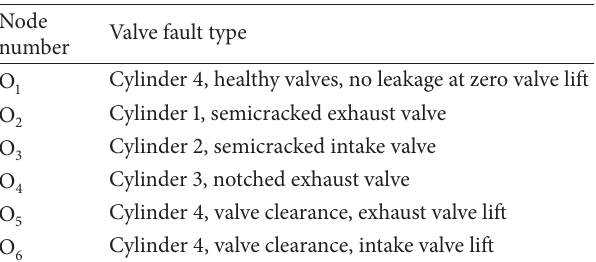
Table 1: Output condition